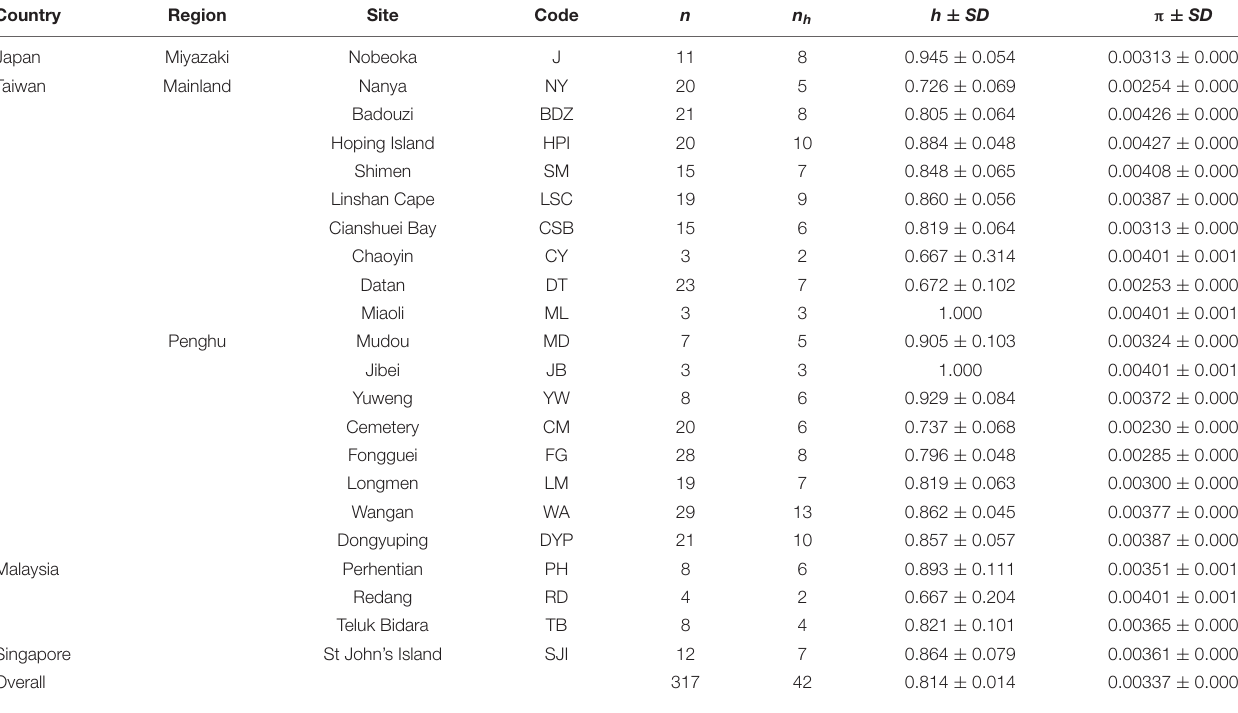
TABLE 1 | Sampling sites, sample size ( n ), number of haplotypes ( n h ), haplotype diversity ( h ± SD ), and nucleotide diversity ( π ± SD ) from samples of Eriphia ferox collected along the west coast of the Pacific.